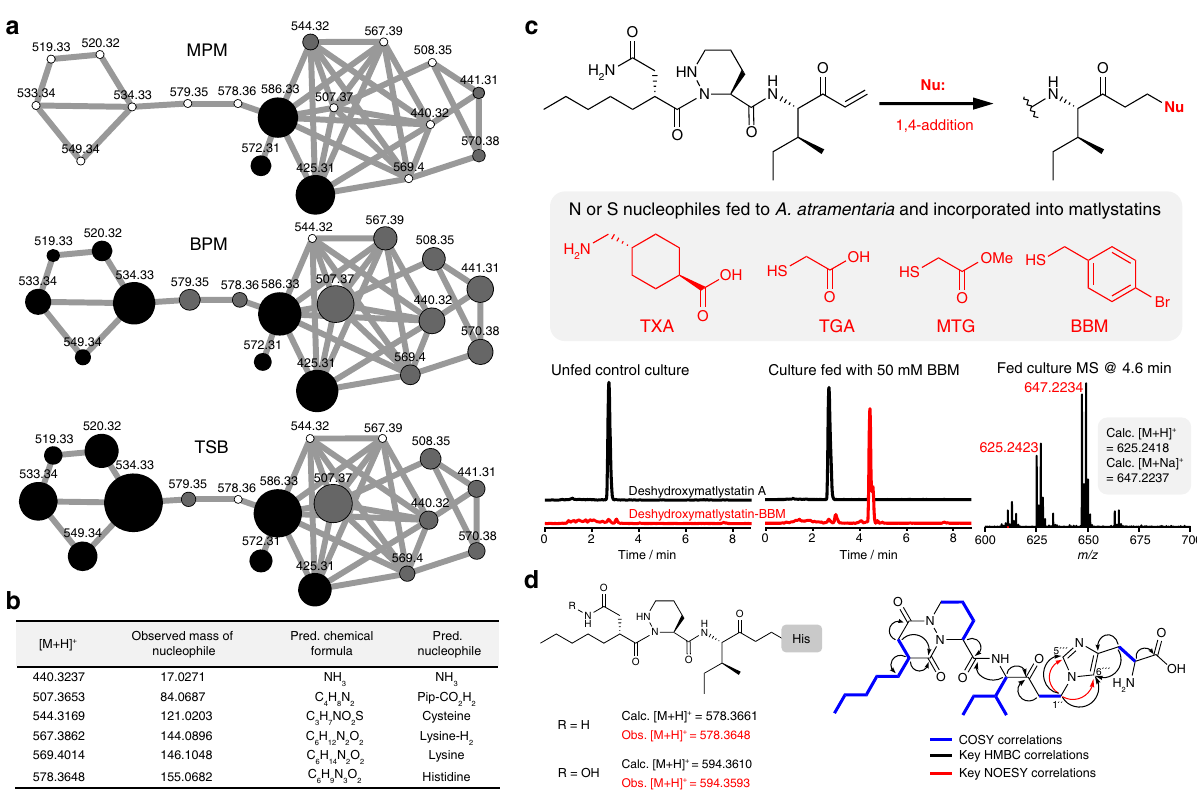
Fig. 5 Production of matlystatin congeners. a MS networking analysis of matlystatin congeners produced by A . atramentaria DSM 43919 in different media. Black nodes indicate metabolites related (hydroxamate, amide, or carboxylate versions) to known matlystatin congeners, gray nodes indicate putative novel matlystatin congeners, and white nodes indicate congeners not detected in that medium. Nodes are sized to re fl ect the relative MS peak intensities. The corresponding cytoscape fi le of the network can be found in the Supplementary Data 1 (matlystatin_network.cys). b Predicted nucleophiles that generate novel deshydroxymatlystatin congeners. c Production of novel matlystatin congeners by feeding unnatural nucleophiles to A . atramentaria DSM 43919. LC-MS data for BBM feeding are shown. d Histidine-containing matlystatin congeners produced by fermentation in histidine-supplemented